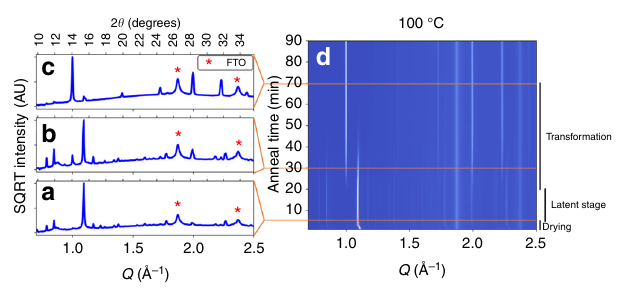
Fig. 3 In-situ X-ray diffraction of perovskite annealing at 100 °C. a – c XRD scans while annealing showing square root intensity to enhance small peaks. XRD scans shown are a 5 min, the end of drying, b 30 min, during the transformation, and c 70 min, near the end of the transformation. d Waterfall composite plot: each horizontal slice corresponds to an XRD pattern at a certain